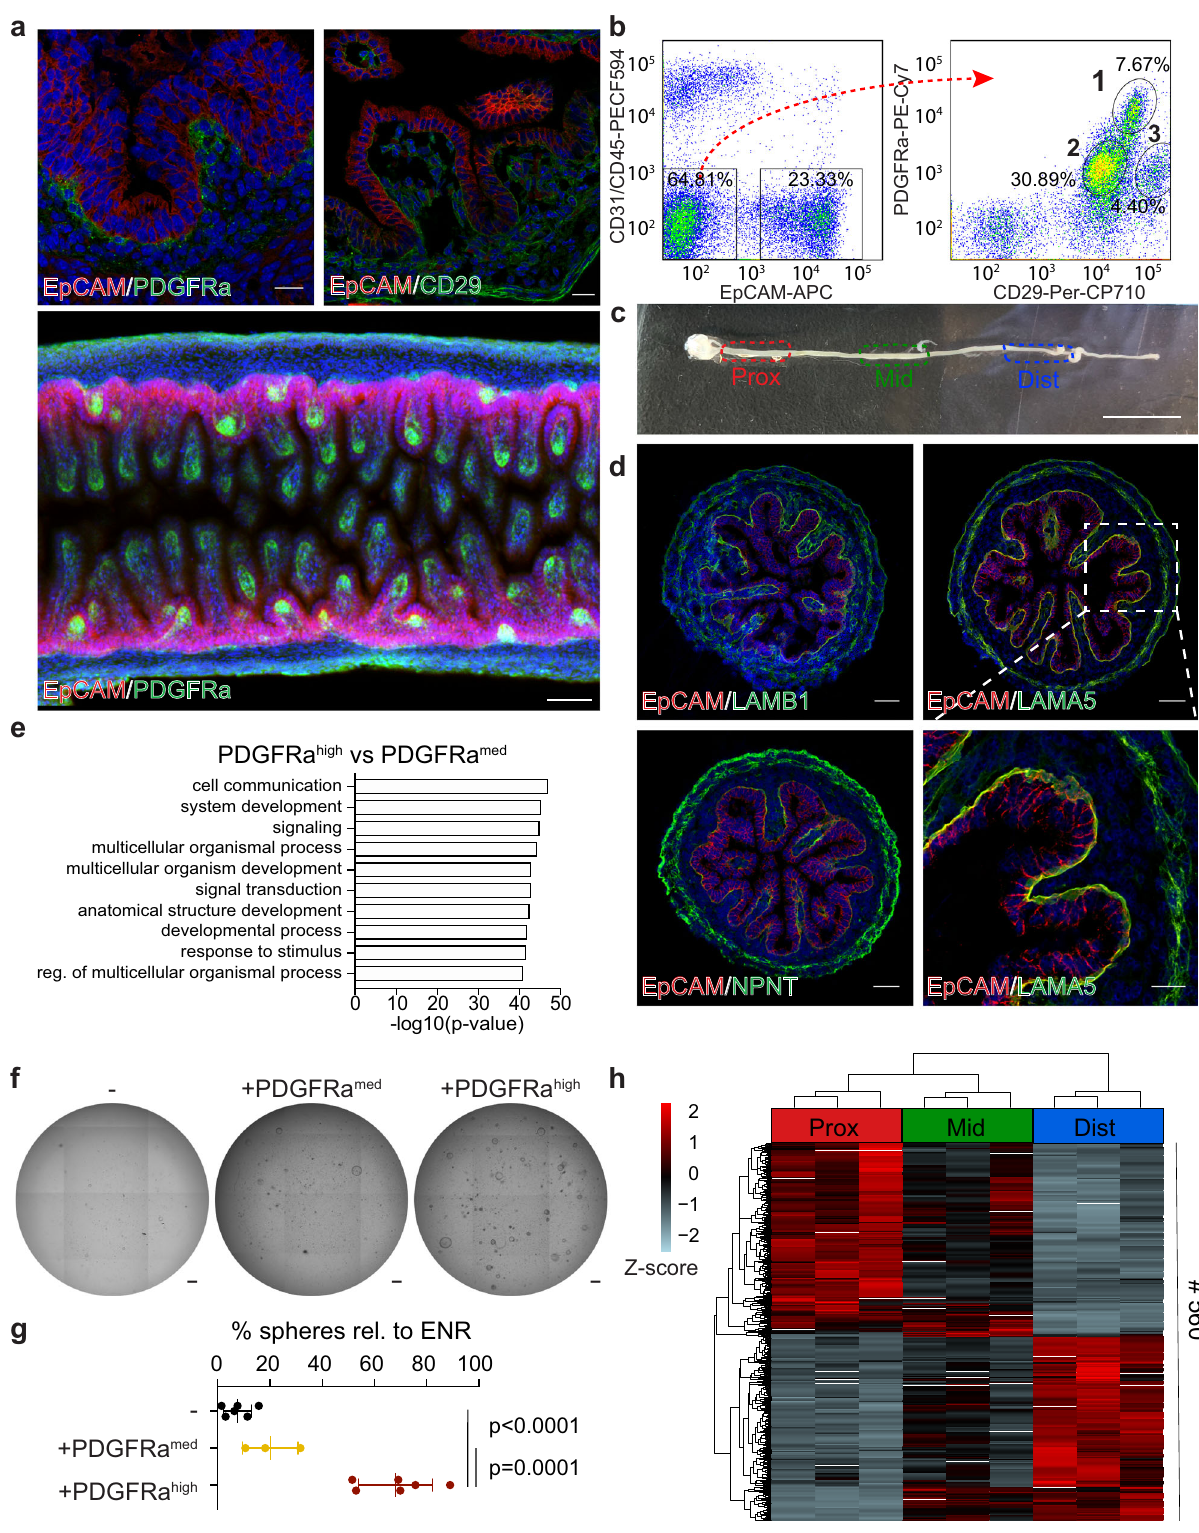
signaling multicellular organismal process multicellular organism development signal transduction anatomical structure development developmental process response to stimulus reg. of multicellular organismal